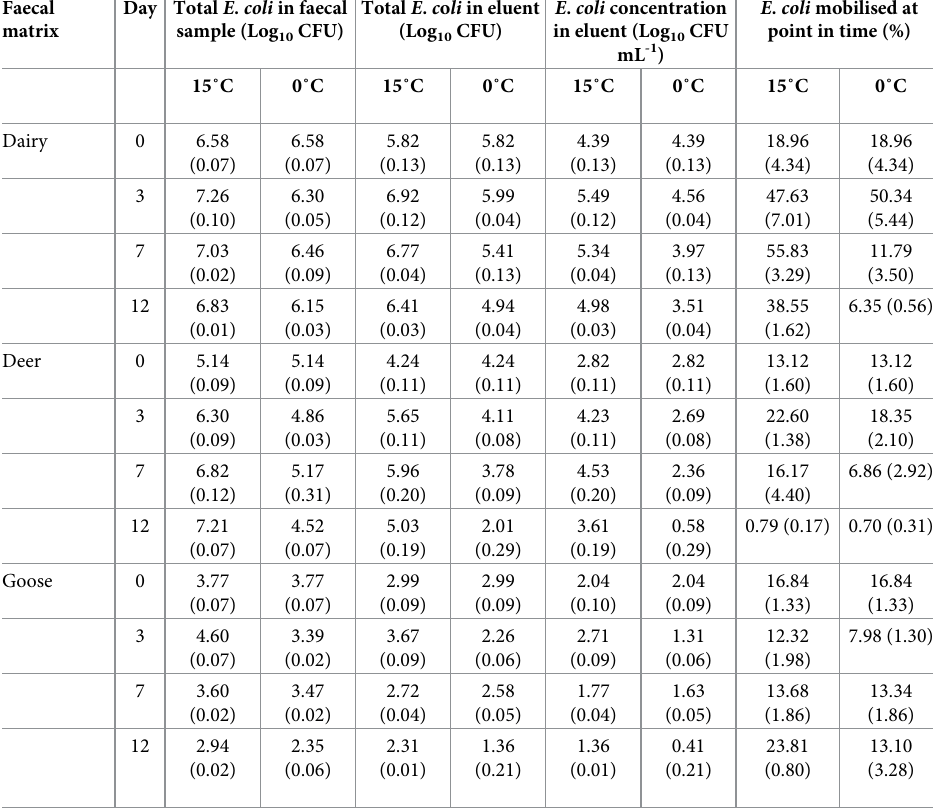
Table 1. Total number of E . coli CFU in faecal and eluent samples, associated E . coli concentrations in eluent sam- ples and percentage of cells mobilised for each time-point. Data are the mean of five replicates ( ± standard error). Faecal